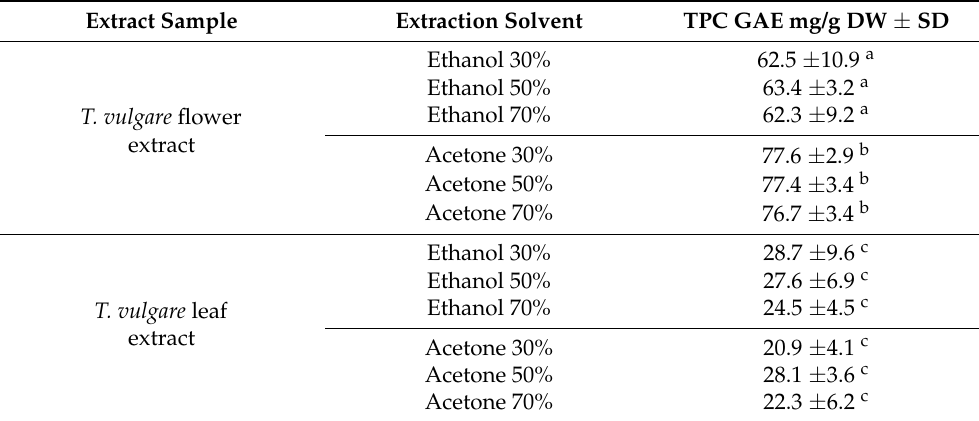
Table 1. Total Phenolic Content of the ethanol and acetone extracts of flowers and leaves of T. vulgare . Extract Sample